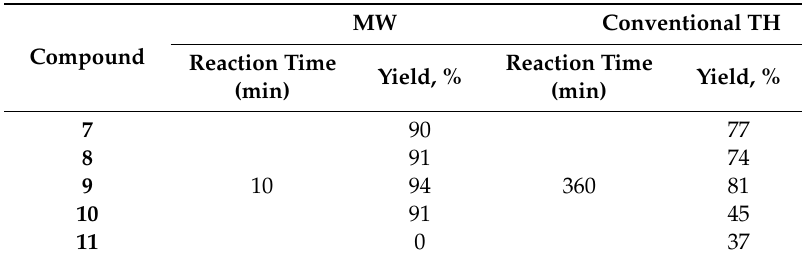
Table 1. The synthesis of pyrrolodiazine derivatives under microwave (MW) irradiation and conventional thermal heating